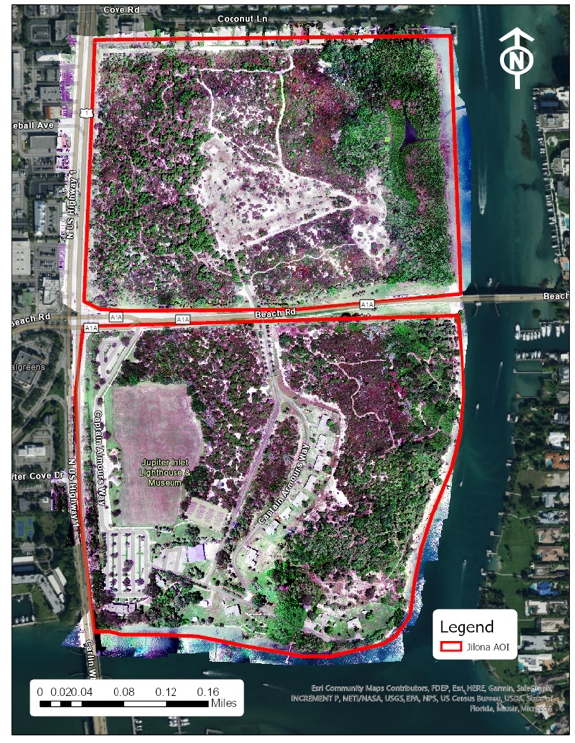
Figure 2: Study area -